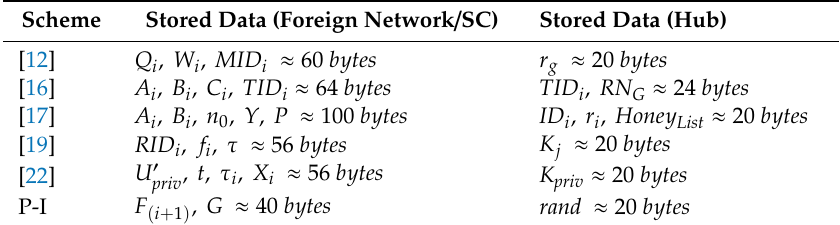
Table 10. Comparison of scheme security requirements.